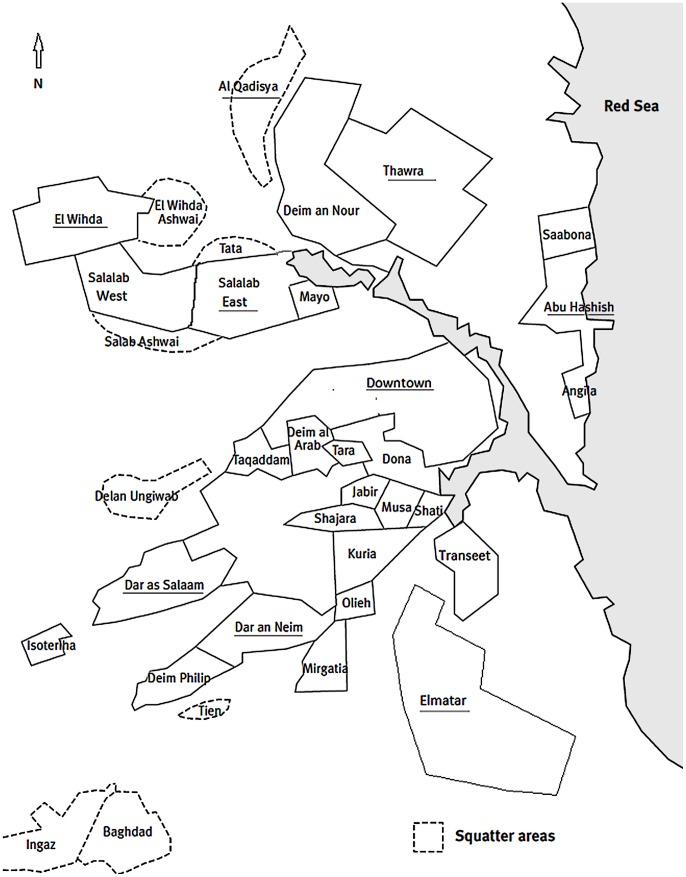
Port Sudan map.Sketch map of Port Sudan city shows approximate location of the study neighborhoods.